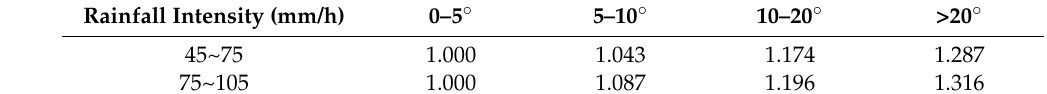
Table 5. Effect of slope and rainfall intensity on runoff coefficient.